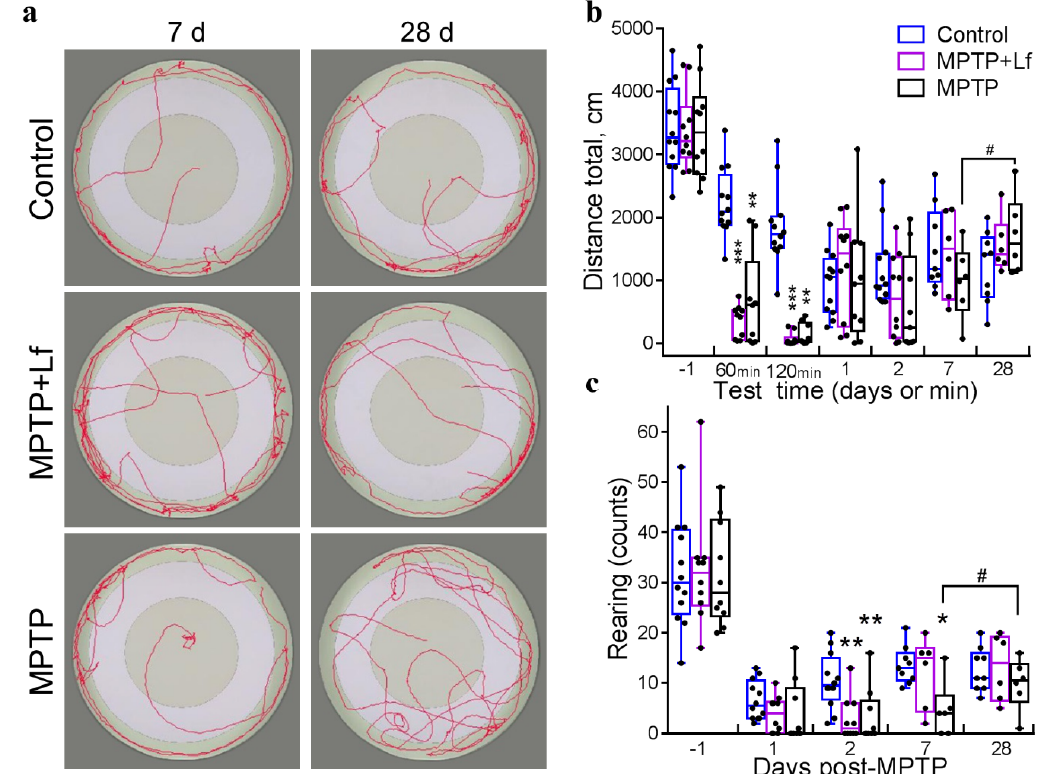
Figure 4. Behavior of mice in open field test after MPTP/saline administration. Representative five minute movement tracks of open field behavior by the mice on day 7 ( left ) and day 28 ( right ) ( a ). Total distance traveled ( b ). Number of rearings ( c ). Each dot represents a single animal. n = 9–12 (from day -1 to day 2), n = 6–9 (days 7, 28) for each group. * p < 0.05, ** p < 0.01, *** p < 0.001 compared to the Control group (saline-treated) at an each time point (Kruskal–Wallis ANOVA followed by post hoc Dunn's multiple comparisons test); # p < 0.05 compared to the same group at the previous time point (Wilcoxon matched pairs test).